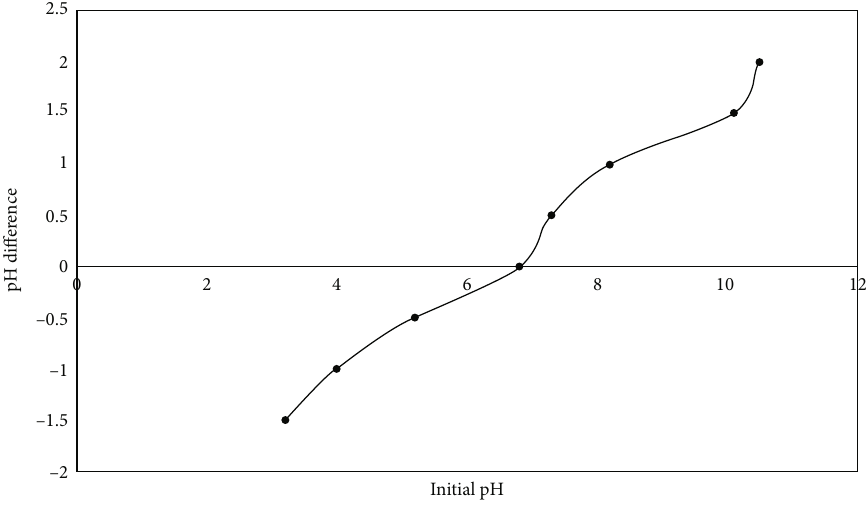
Figure 4: The graph determining pHzpc of breadfruit leaf biochar adsorbent.